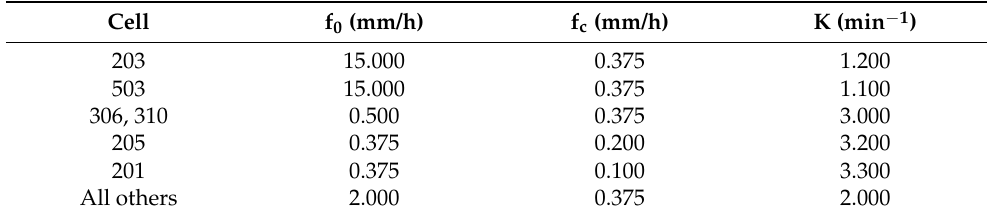
Table 1. Horton model parameter values introduced to surfaces in IBER after calibration has been